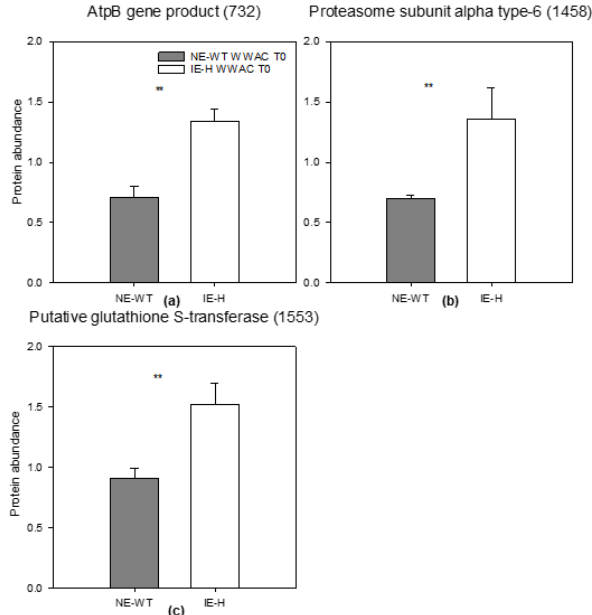
Figure 5. Different abundance of proteins in control conditions in actual climate. The abundances of atpB gene product (732) ( a ), proteasome subunit alpha type 6 (1458) ( b ) and putative glutathione S-transferase (1553) ( c ) in non-emitting wild-type = NE-WT (grey) and isoprene-emitting line = IE-H (white) under control condition (WW) are reported in control plants (at T0). Means ( n = 3) + SE are shown. A Student’s t -test was performed to determine the statistical significance (** p < 0.01) of differences in the abundance of proteins between genotypes.